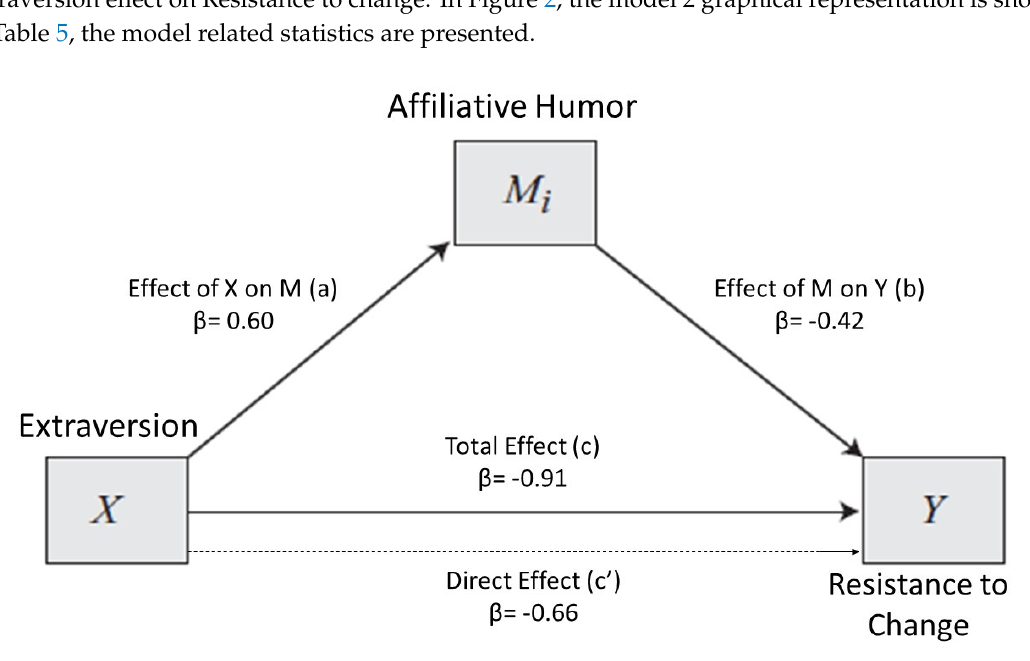
Figure 2. Model 2. Relationship between Extraversion and Resistance to Change, with Affiliative Humor as a mediator. k² mediator effect size = 0.13. Table 5. Model 2. Mediation analysis statistics. In the upper part of the table, the indexes related to